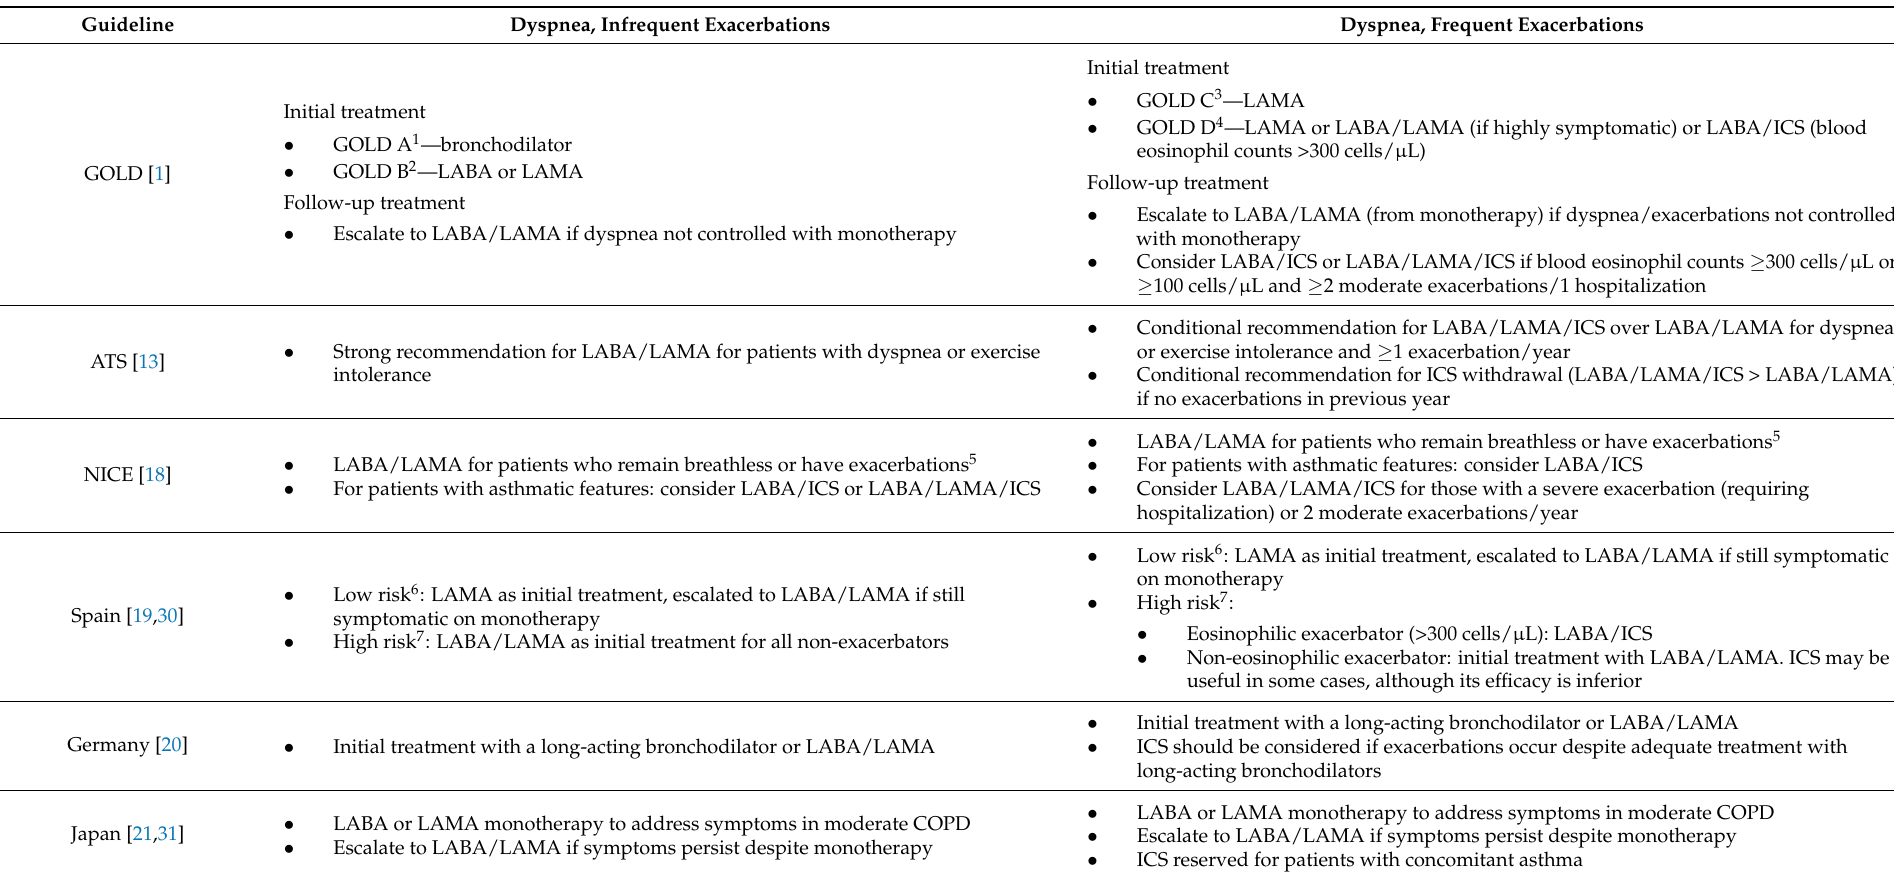
Table 2. Global consensus on LABA/LAMA in the long-term management of